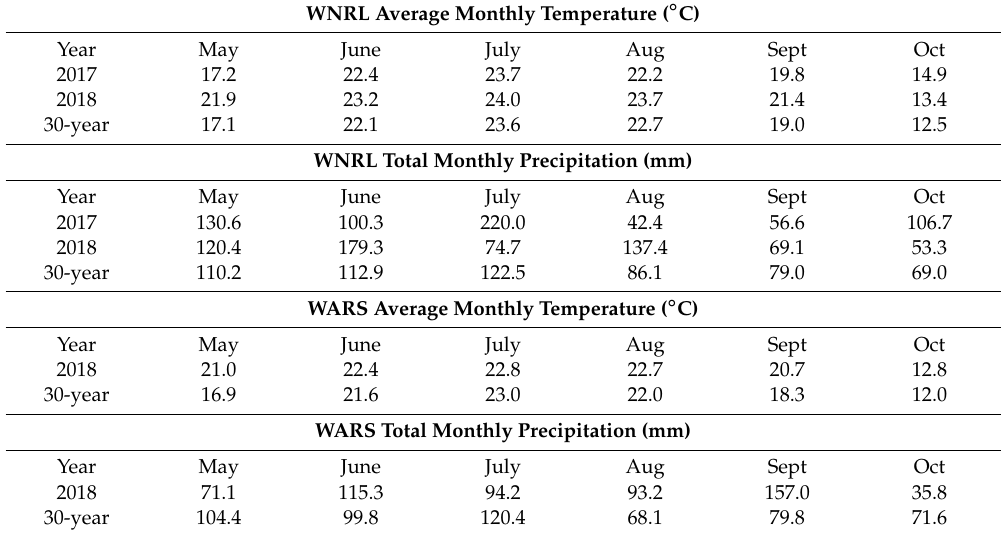
Table 1. Average monthly temperature and monthly cumulative precipitation and the monthly 30-year averages (1989–2018) for the Waterman Agricultural and Natural Resources Laboratory (WNRL) in 2017 and 2018, and the Western Agricultural Research Station (WARS) in 2018.